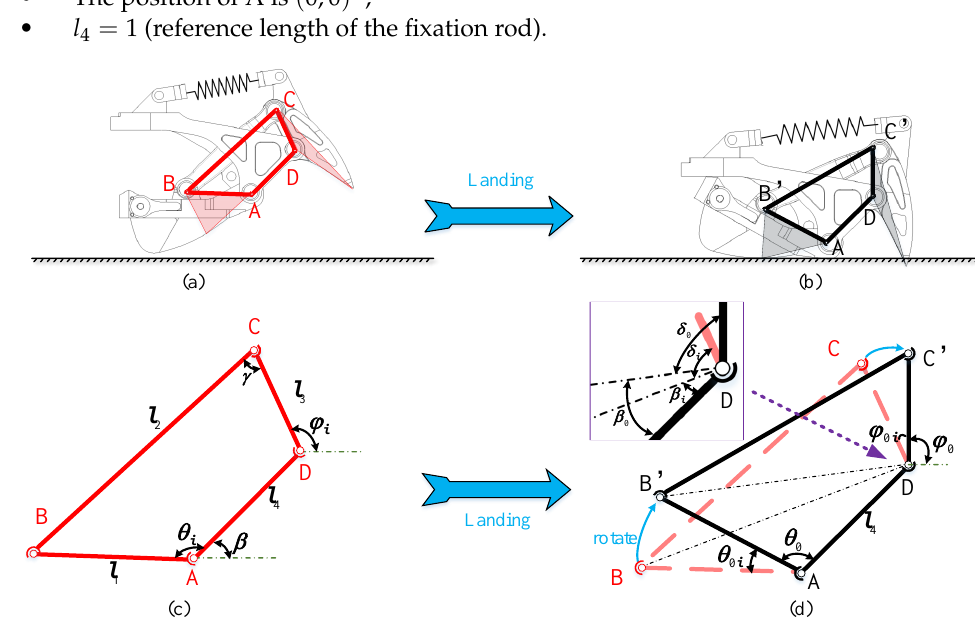
Figure 6. The four-bar linkage of the bionic mechanism. A, B, C, and D are the vertices of the four-bar linkage. BC is the connecting rod; AD is the fixation rod; CD is the claw; and B is the position of the sliding block. ( a , b ) describe the relationship between the four-bar linkage and the bionic mechanism during the landing motion. ( c , d ) show a state transition from “in the air” (ABCD) to “landing on soft ground” (AB (cid:48) C (cid:48) D), as defined in Figure 4. After the state switch is complete, the angle between the touchdown rod and the fixation rod changes from θ i to θ 0 . Meanwhile, the angle between the claw and the fixation rod changes from ϕ i to ϕ 0 . The black lines in the two subfigures indicate the same state of the bionic mechanism. l 1 , l 2 , l 3 , and l 4 are the lengths of AB, BC, CD, and AD, respectively. Obviously, because the sliding block remains still, we have AB (cid:48) = AB, B (cid:48) C (cid:48) = BC, and C (cid:48) D = CD. The purple rectangle is an enlarged view around vertex